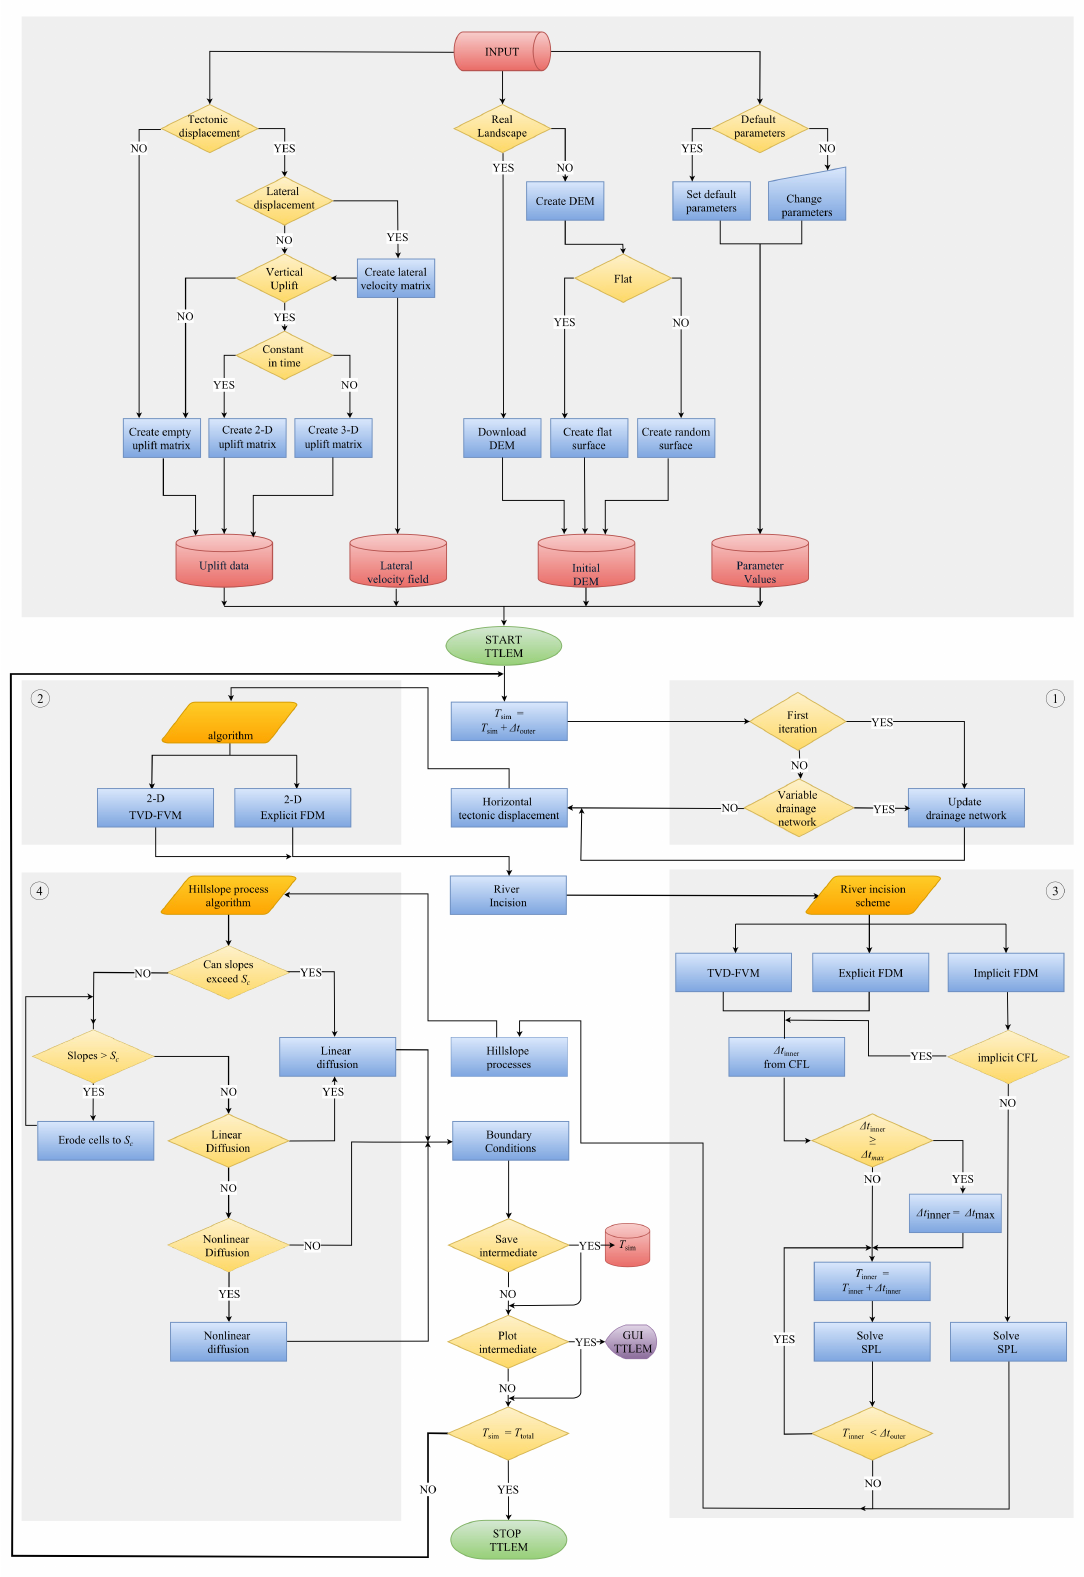
Figure A1. Schematic representation of the TTLEM model flow. The numbered methods correspond with the paragraphs from Sect. 3 in the main